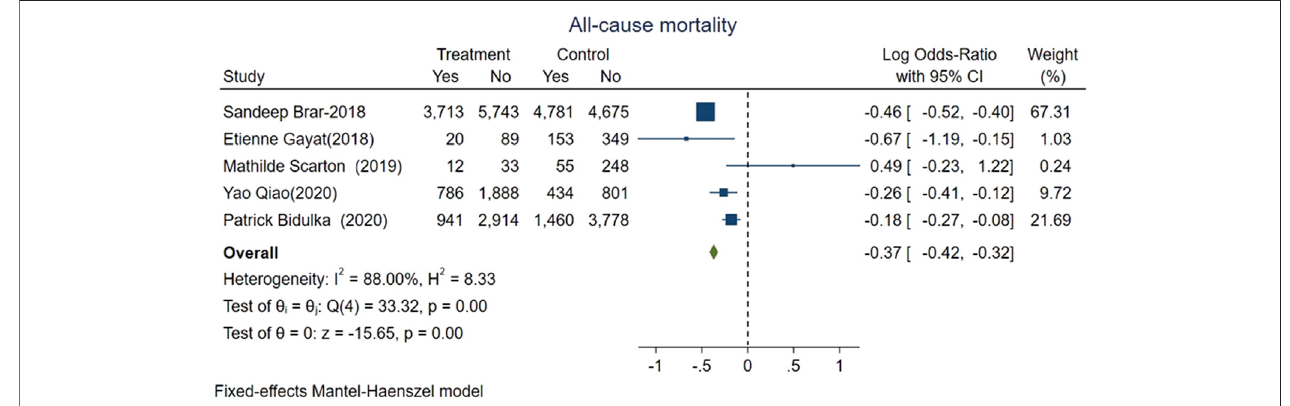
FIGURE 2 | Forest plot showing reduced risk of all-cause mortality comparing ACEi/ARB users vs. nonusers after AKI. Fixed effects of Mantel-Haenszel model.